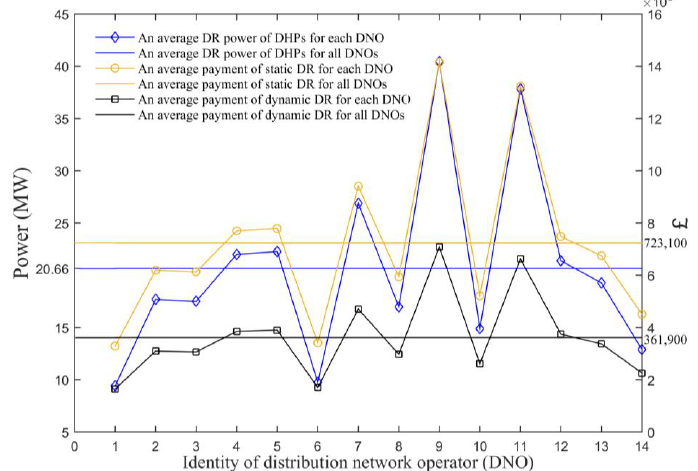
Figure 9. An estimate of average demand reduction and average payment for the static/dynamic DR controller of DHPs for each DNO region in the UK based on the current electricity market.